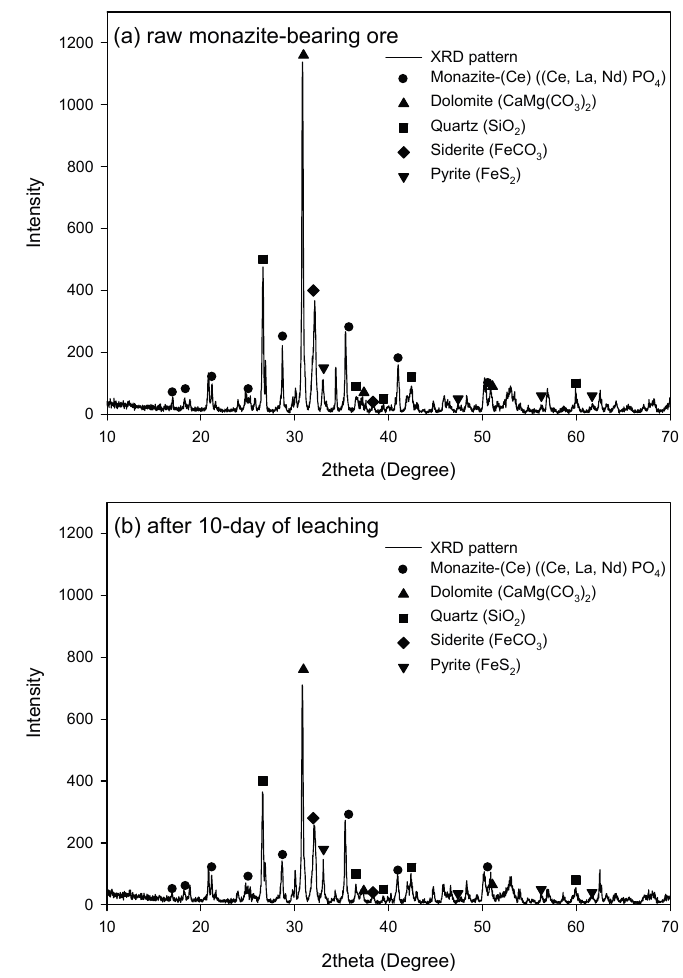
Figure 6. X-Ray diffraction (XRD) patterns of the monazite-bearing ore before and after leaching (10